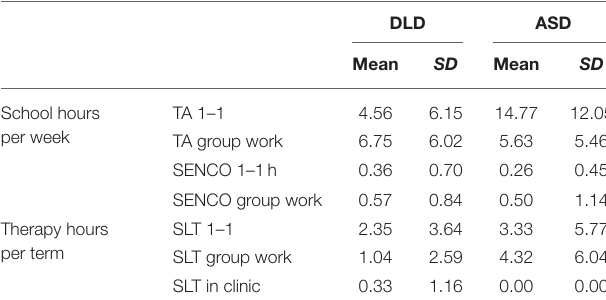
TABLE 3 | Mean ( SD ) hours support reported by SENCOs during wave